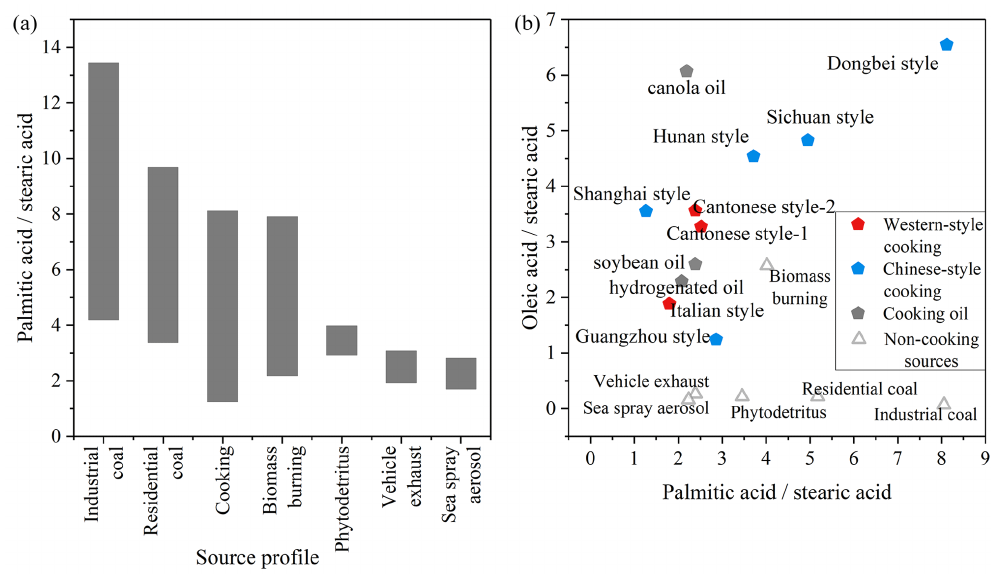
Figure 4. Ratio of fatty acids (P / S) in organic molecular substances emitted directly from different sources (a) and ratio of fatty acids (P / S versus O / S) emitted by different types of cooking sources and non-cooking sources (b) (Bikkin et al., 2019; Cai et al., 2017; Hays et al., 2002; He et al., 2004; Oliveira et al., 2007; Pei et al., 2016; Rogge et al., 1993; Schauer et al., 2001, 2002; Simoneit, 2002; Zhang et al., 2008; Zhao et al.,